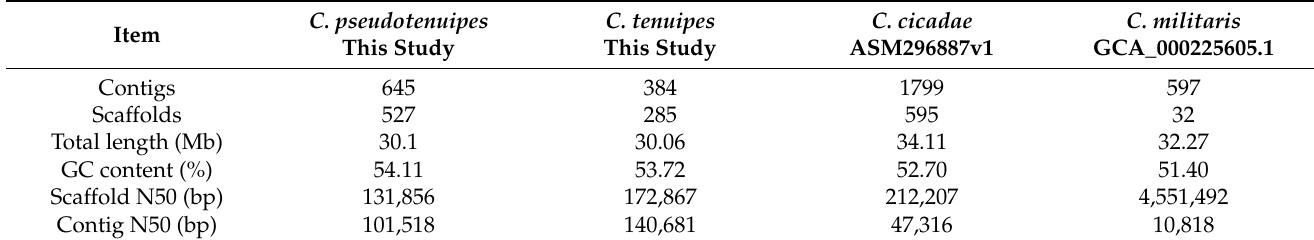
Table 2. Characteristics of C. pseudotenuipes , C. tenuipes , C. cicadae , and C. militaris